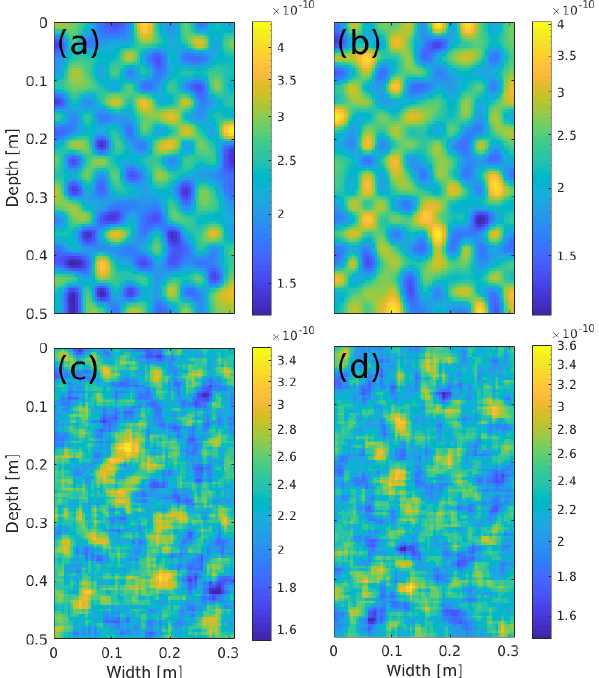
Figure B1. The distribution of the intrinsic permeability κ (m 2 ) used for the sensitivity analysis of Bauters’ paradox. The distribu- tions satisfy the following: (a) κ max /κ min ≈ 3 . 40, (b) κ max /κ min ≈ 3 . 48, (c) κ max /κ min ≈ 2 . 28, and (d) κ max /κ min ≈ 2 . 42. Intrinsic permeability values are color coded according to the color bar on the